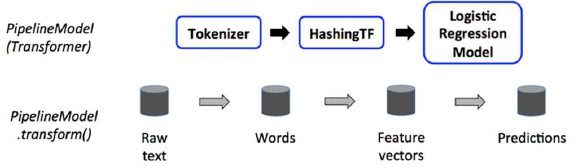
Figure 7. DataFrame goes through pipelineModel [10]